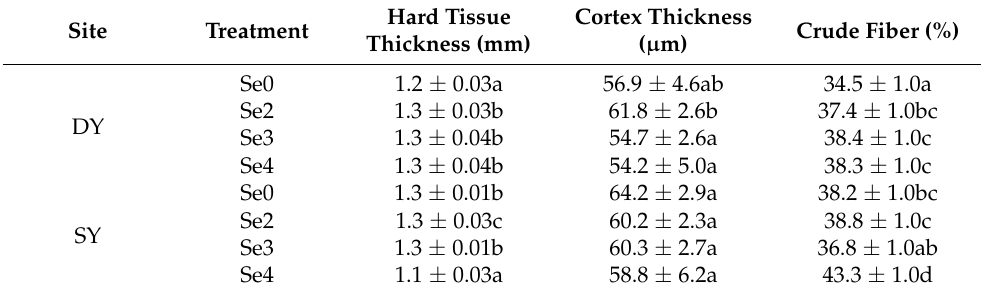
Table 7. Effects of Se fertilizer application on stem cortex of maize at locations DY and SY.